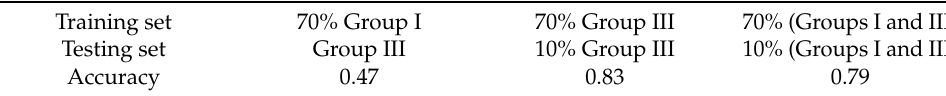
Table 10. Accuracy results of Group